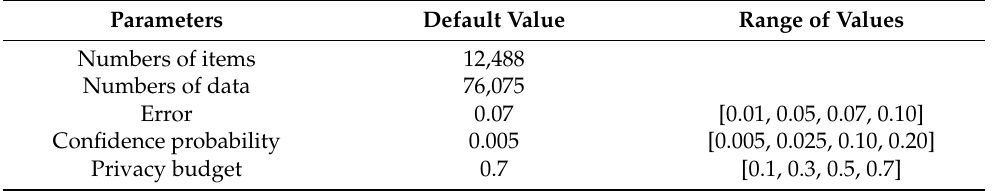
Table 1. Experimental parameters